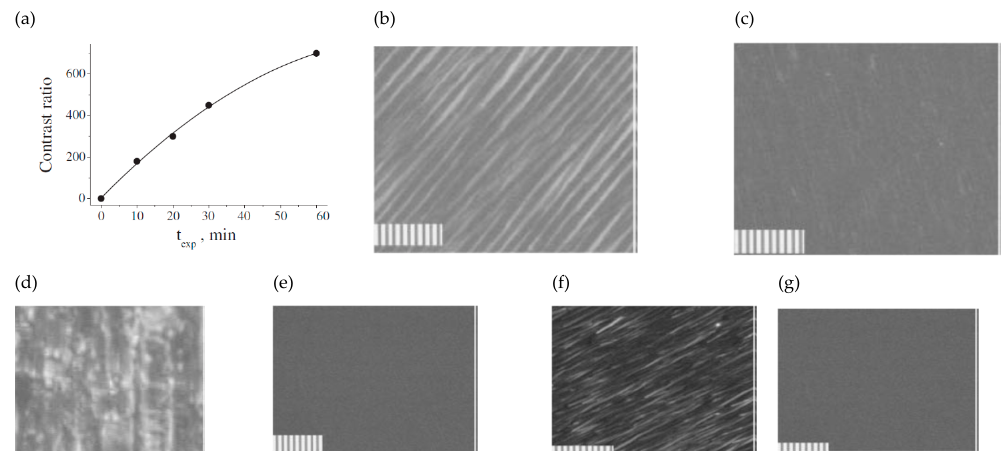
Figure 2. ( a ) Contrast ratio dependence on the exposure time for FLC cells, which were filled with the compound FLC-451A. The SD-1 layer was illuminated by linearly polarized UV light ( λ = 365 nm) at the normal incidence with the power density of 6 mW/cm 2 . The FLC layer thickness is 4.85 μ m. Polarized optical microscopy images: dark state of two photo-aligned cells filled with the FLC-451A, the cell gap is 1.5 μ m; the irradiation time of the SD-1 surface is ( b ) 10 min and ( c ) 60 min. Here, the SD-1 layer thickness is 13 nm. ( d ) Polarized optical microscopy images of the dark state of two cells filled with the FLC-445 with different boundary conditions: symmetric (both ITO layers are covered with 20 nm rubbed PMDA-ODA layers) and ( e ) asymmetric, i.e., one ITO layer is covered with the 20 nm rubbed PMDA-ODA layer. The FLC layer thickness is 1.5 μ m for both cells ( d,e ). ( f ) Polarized optical microscopy images of the dark state of two photo-aligned cells, which were filled with the helix-free FLC-445: the irradiation time of the SD-1 surface is 10 min; ( g ) the irradiation time of the SD-1 surface is 60 min. The SD-1 layer thickness is 13 nm, and the FLC layer thickness is 1.5 μ m. The insets in e – g show the scale of images. The striped structure of the insets has 8 μ m periodicity. Helix-free FLCs are very sensitive to the alignment quality of the dye layer. Therefore, in Figure 2f,g we observe more uniform alignment than the deformed helix FLC mixtures. The contrast ratio of the cell filled with the helix-free FLC-445 was superior at 1500:1 for t exp = 60 min and 400:1 for t exp = 10 min. This fact allows us to conclude that the helix-free structure of FLCs is preferable for photo- alignment.